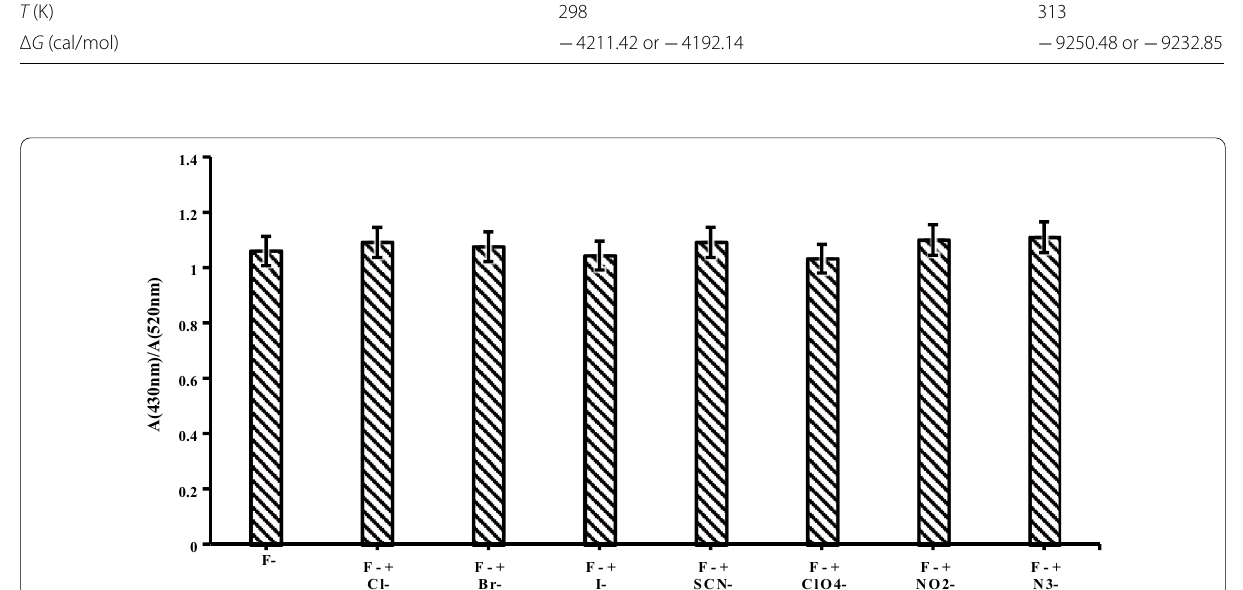
In and ARS In‑ARS and F 1:1.15